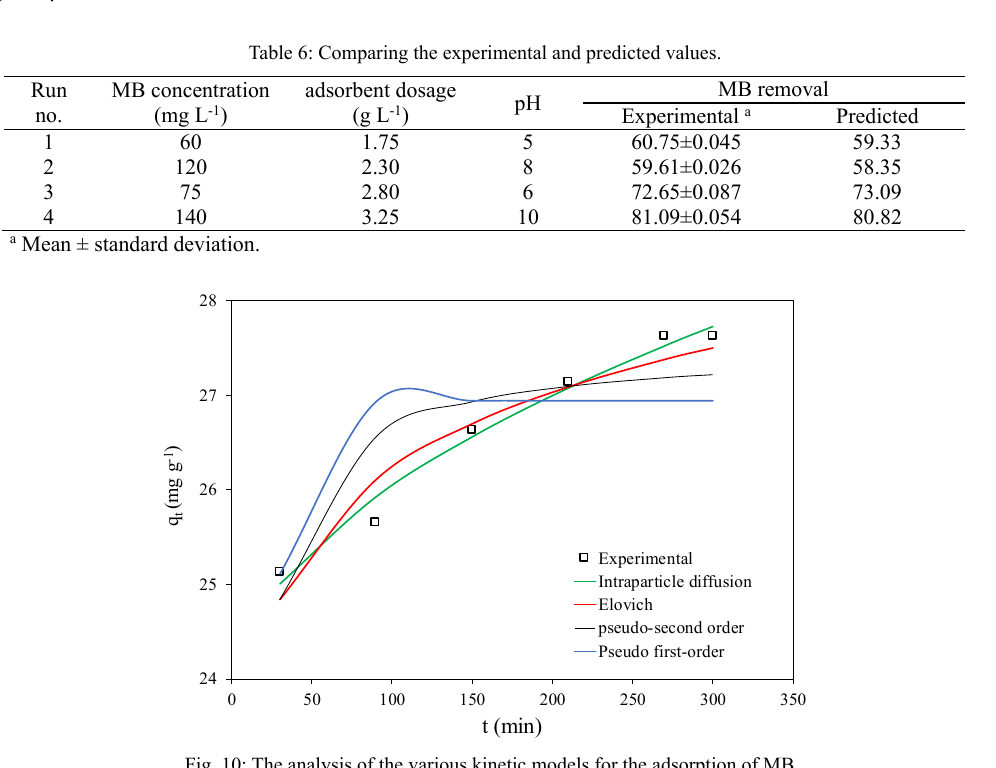
Fig. 10: The analysis of the various kinetic models for the adsorption of MB Fig. 10. The analysis of the various kinetic models for the adsorption of MB on SD/MgO at 298K (C o : on SD/MgO at 298K (C : 100 mg L -1 ) by the non-linear o 100 mg L -1 ) by the non-linear method.